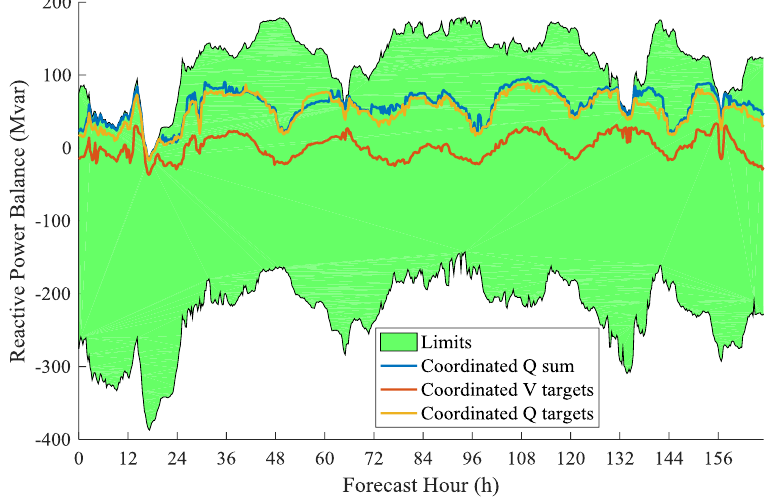
Figure 13. Reactive power exchange between transmission and distribution grid (weekly).